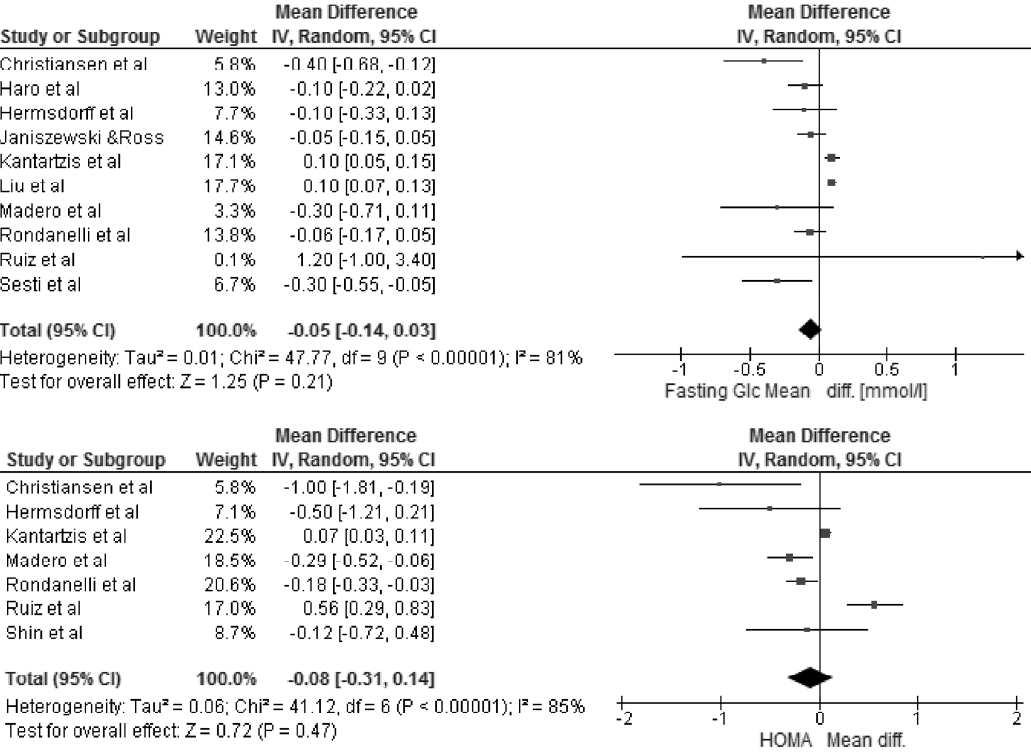
Figure 6. Forest plot of the random-effects meta-analysis of changes in Fasting Glucose and HOMA-IR according to reduction in energy intake shown as polled standard differences in the means with 95% Cis and in randomized and non-randomized trials. * For each study, the square represents the point estimate of the intervention effect. Horizontal lines join the lower and upper limits of the 95% CI of this effect. The area of shaded squares reflects the relative weight of the study in the meta-analysis. Diamonds represent the subgroup mean difference and pooled mean differences. CI indicates confidence interval.